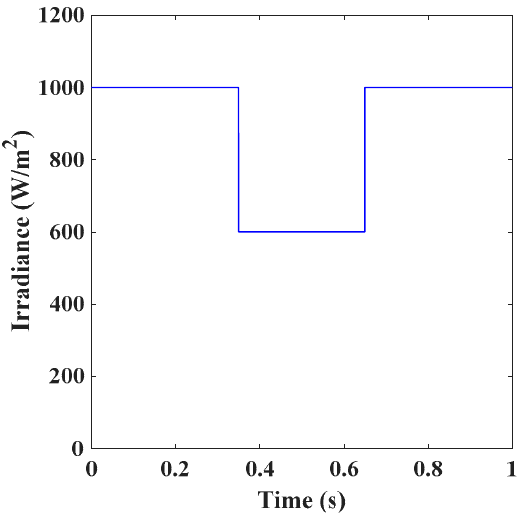
Figure 8. Sudden Irradiance change at 25 °C.